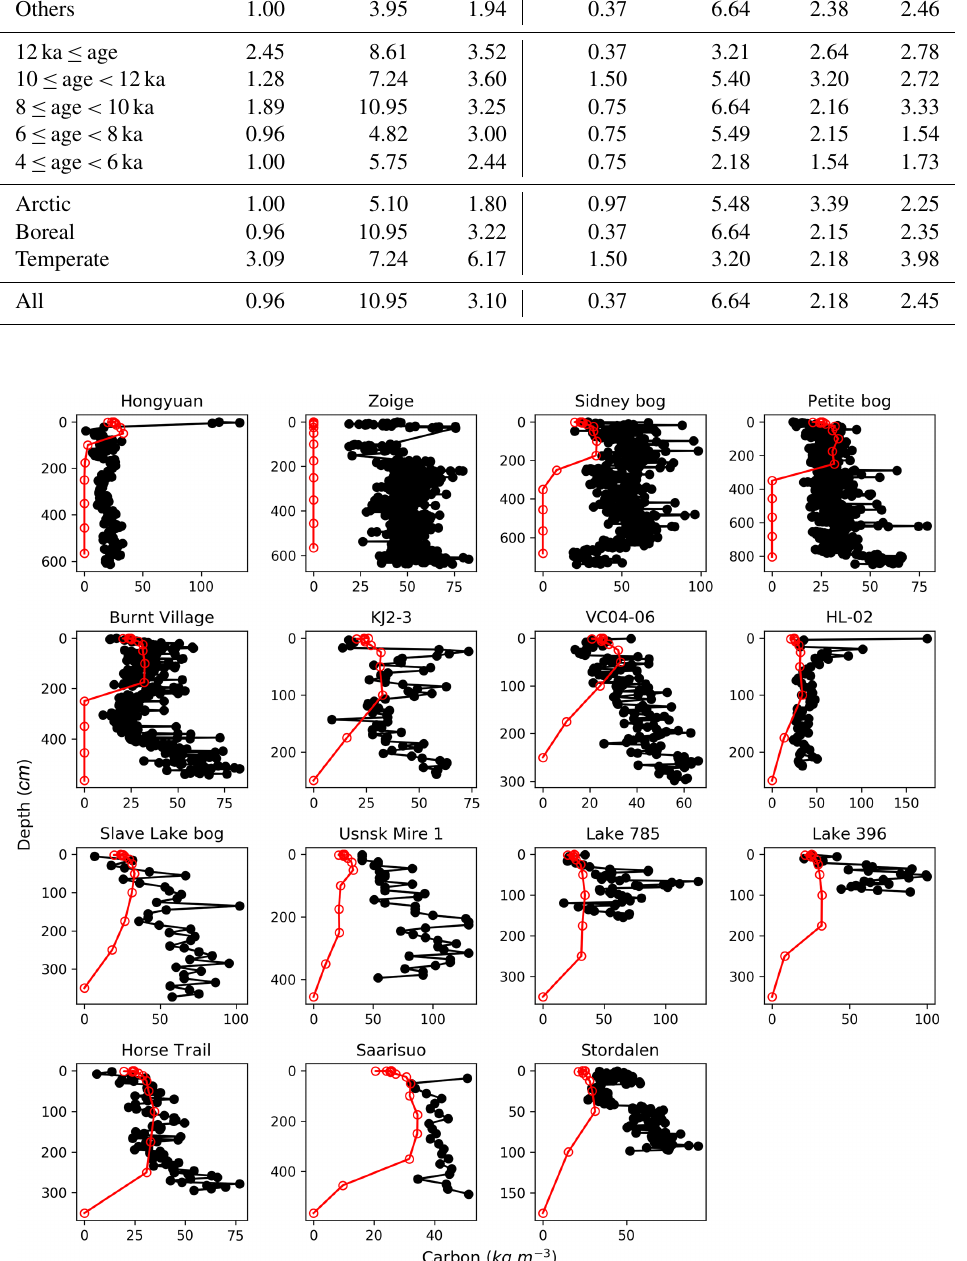
Figure 3. Observed (black) and simulated (red) vertical profiles of soil C, at the 15 sites where peat age, depth, bulk density, and carbon fraction have been measured (Table S1). The black circles indicate depths of measurements; the red circles indicate the depth of each soil layer in the